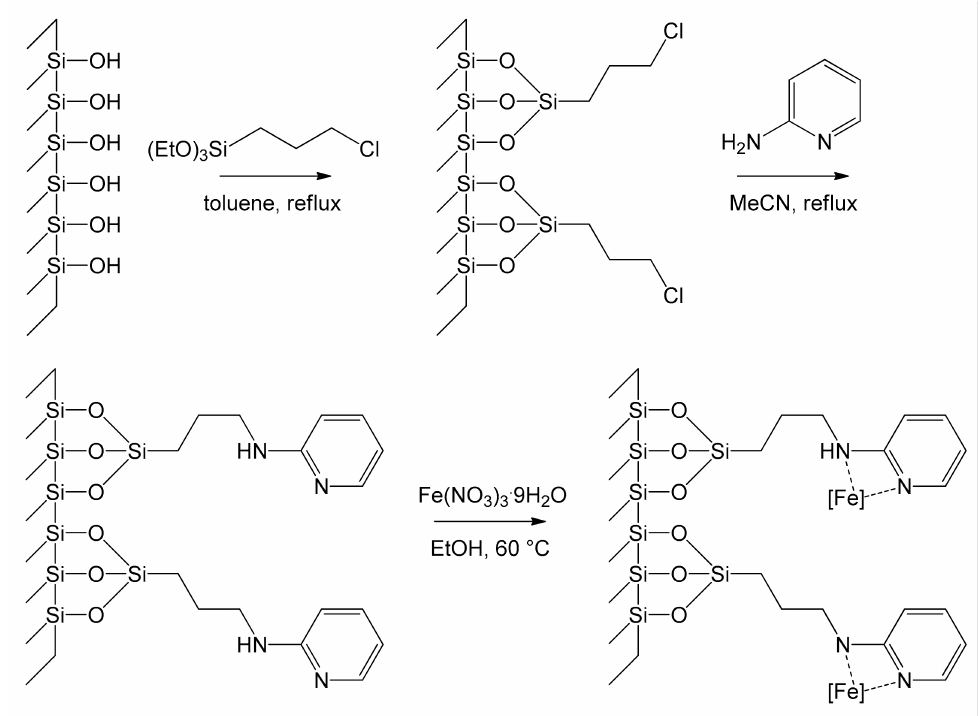
Figure 9. The stepwise preparation of MCM-Py-Fe(III) from MCM-41, [Fe] = anchored complex